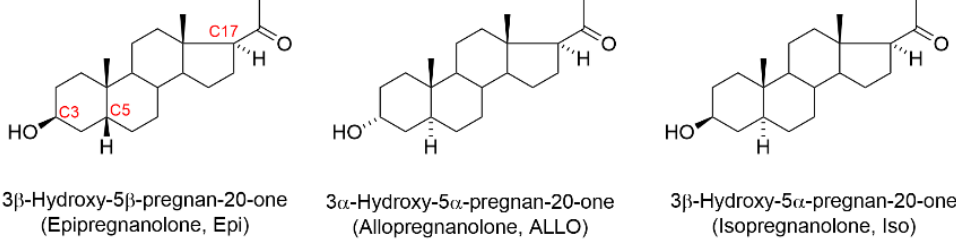
Figure 1. Structures of epipregnanolone (Epi), allopregnanolone (ALLO), and isopregnanolone (Iso). When the rings of a steroid are denoted as projections onto the plane of the paper, the α -substituent (hashed bond) is located below the plane, and the β -substituent (bold bond) above the plane of the paper. The important ring numbering positions are highlighted in red for epipregnanolone.